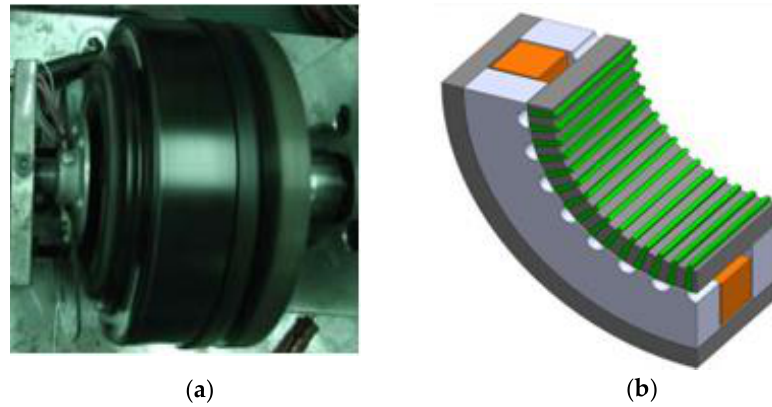
Figure 7. Monstrous fan with permanent magnet transverse flux motor technology ( a ) Outer rotor BLDC motor ( b ) transverse flux motor (TFM) by the ETM Company.